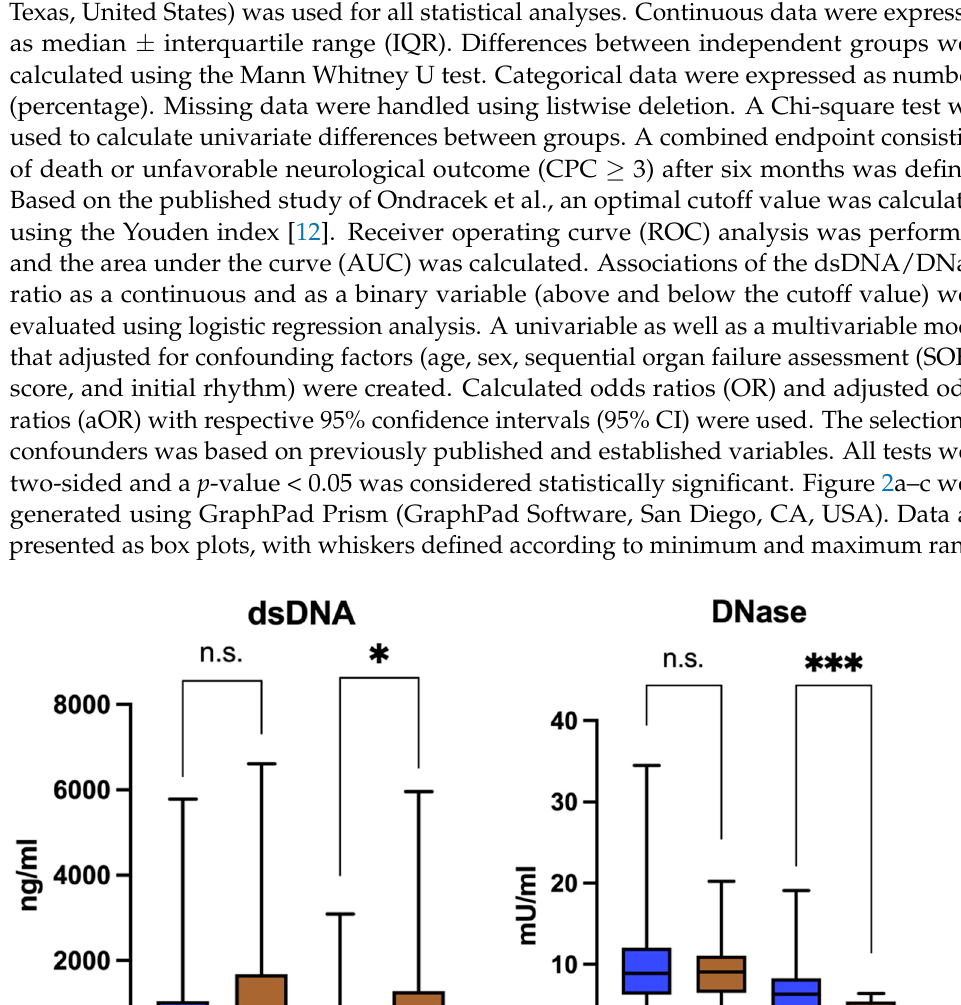
( c ) Figure 2. Boxplots comparing ( a ) dsDNA [ng/mL] after 24 and 96 h, ( b ) DNase [mU/mL] after 24 and 96 h, ( c ) dsDNA/DNase ratio after 24 and 96 h. Abbreviations: 24 h (+): value after 24 h in